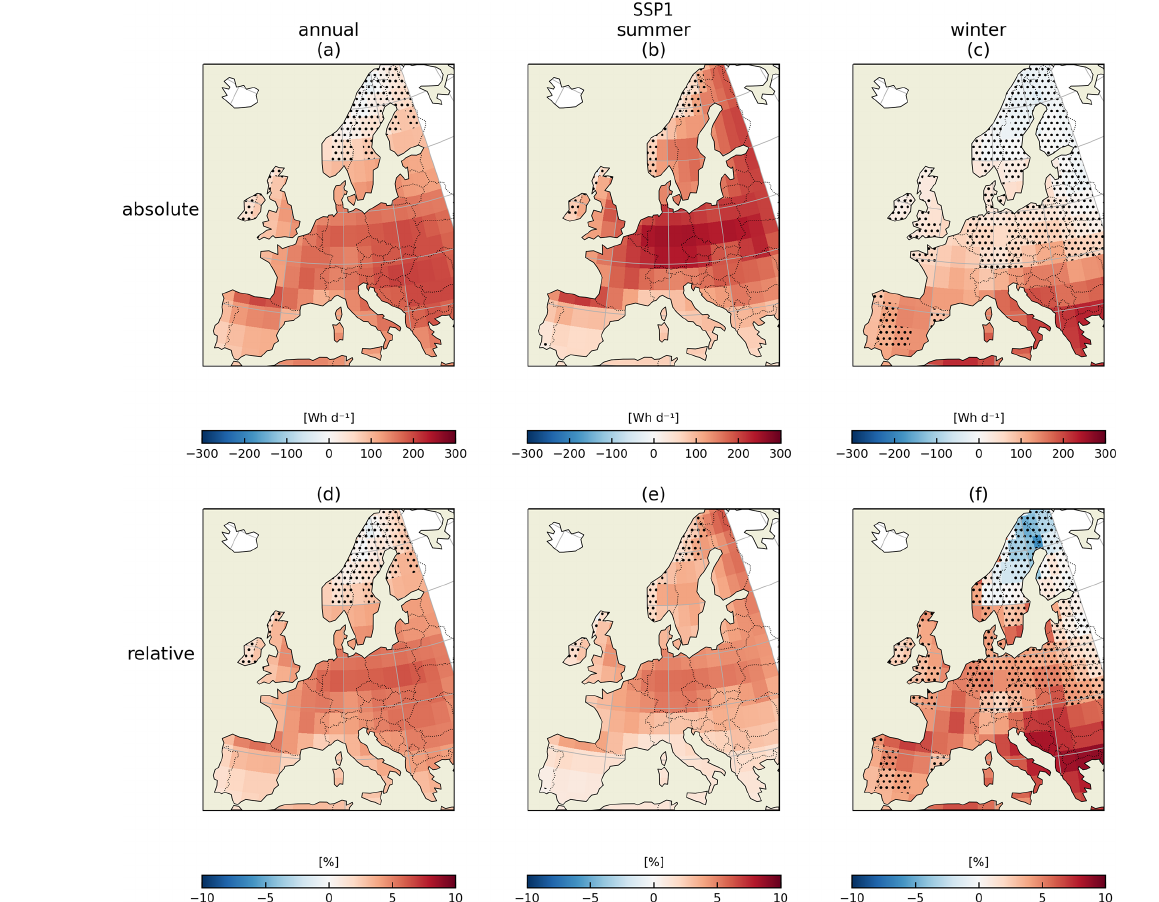
Figure 3. Impacts of climate change on PV generation in SSP1-2.6. Multi-model annual (left), summer (June, July, and August; middle), and winter (December, January, and February; right) (a) – (c) mean absolute change (Whd − 1 ) and (d) – (f) relative change (%) in simulated PV electricity generation between the 2081–2100 period and the 1995–2014 period. The dots signify less than 75% model agreement in the sign of the projected